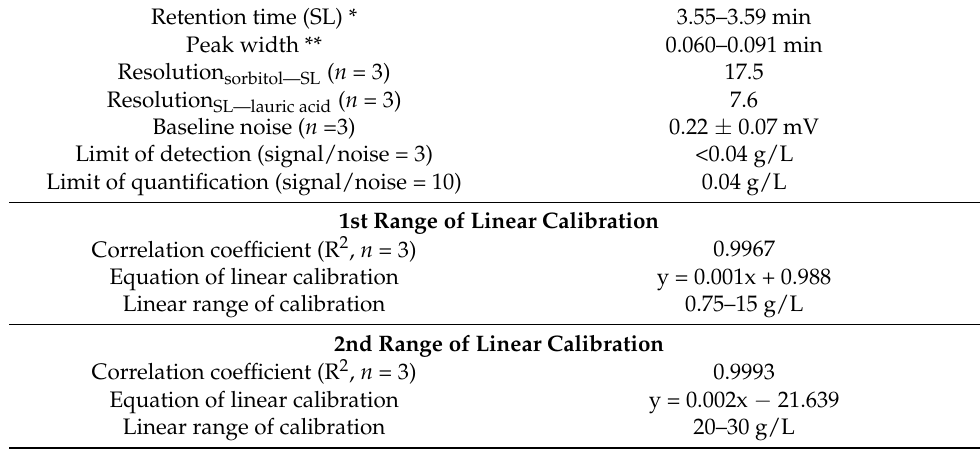
Table 1. Chromatographic and analytical characteristics of SL analysis using